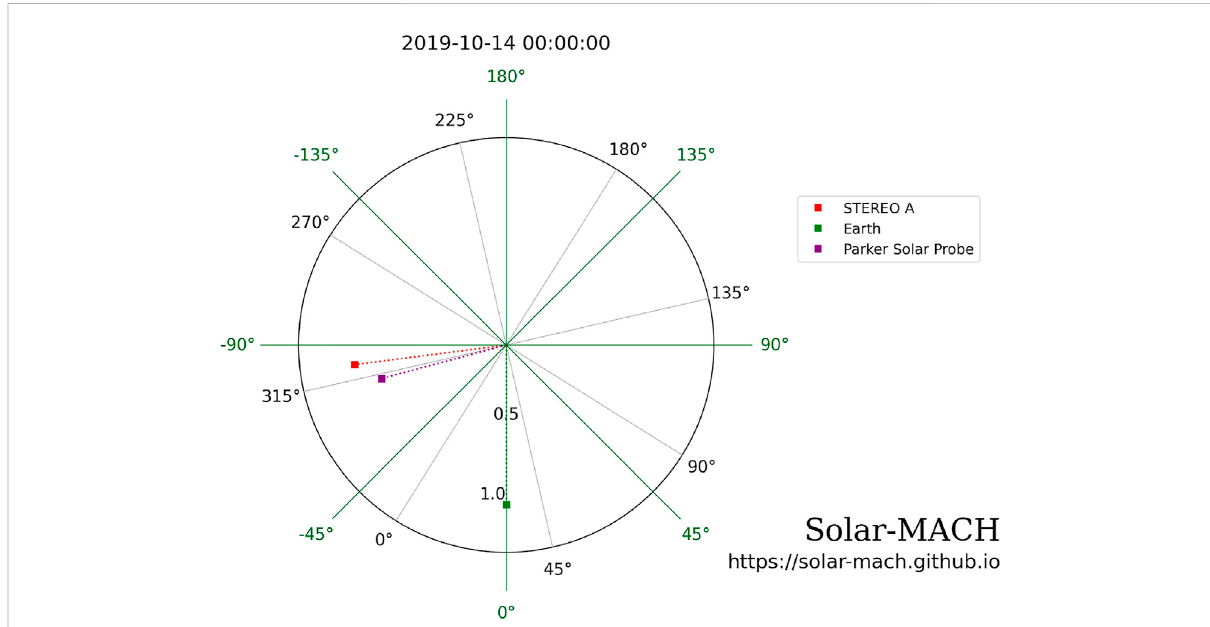
FIGURE 1 The locations of STA, PSP, and Earth on the equatorial plane on 14 October 2019, as indicated by the legend (generated by the Solar MAgnetic Connection Haus (Solar-MACH) tool; see https://da.gd/juUKDZ). The black (green) labels are the Carrington (Stonyhurst)